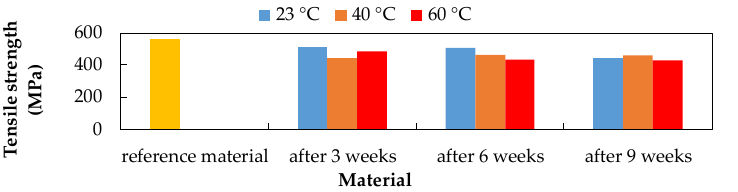
lowest tensile strength value was observed after exposure to 15% H 2 SO 4 at 40 °C (361.95 MPa), which represents a 34.83% decrease. As a result of the CFRP composite exposure to 20% NaCl aqueous solution (Figure 4), the lowest tensile strength values were recorded at a temperature of 60 °C. 23 °C 40 °C 60 °C